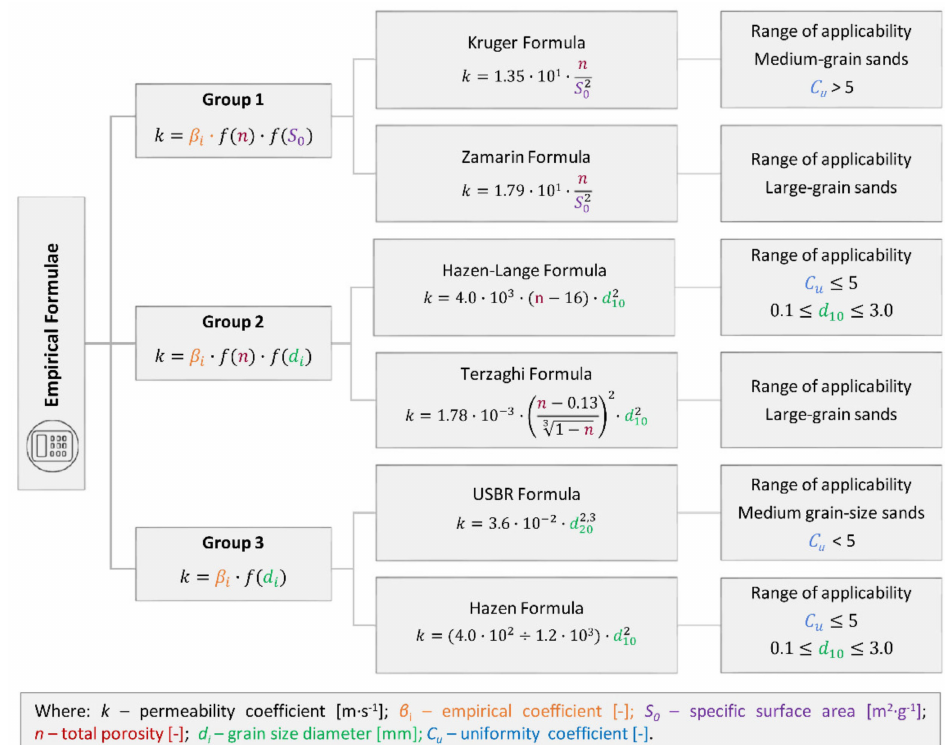
Figure 5. Other empirical formulae. The differences between the formulae are marked in colours: Kruger Formula [17,38], Hazen-Lange Formula [38,39], Hazen Formula [38,39], USBR Formula [17], Zamarin Formula [22,38,40], Terzaghi Formula